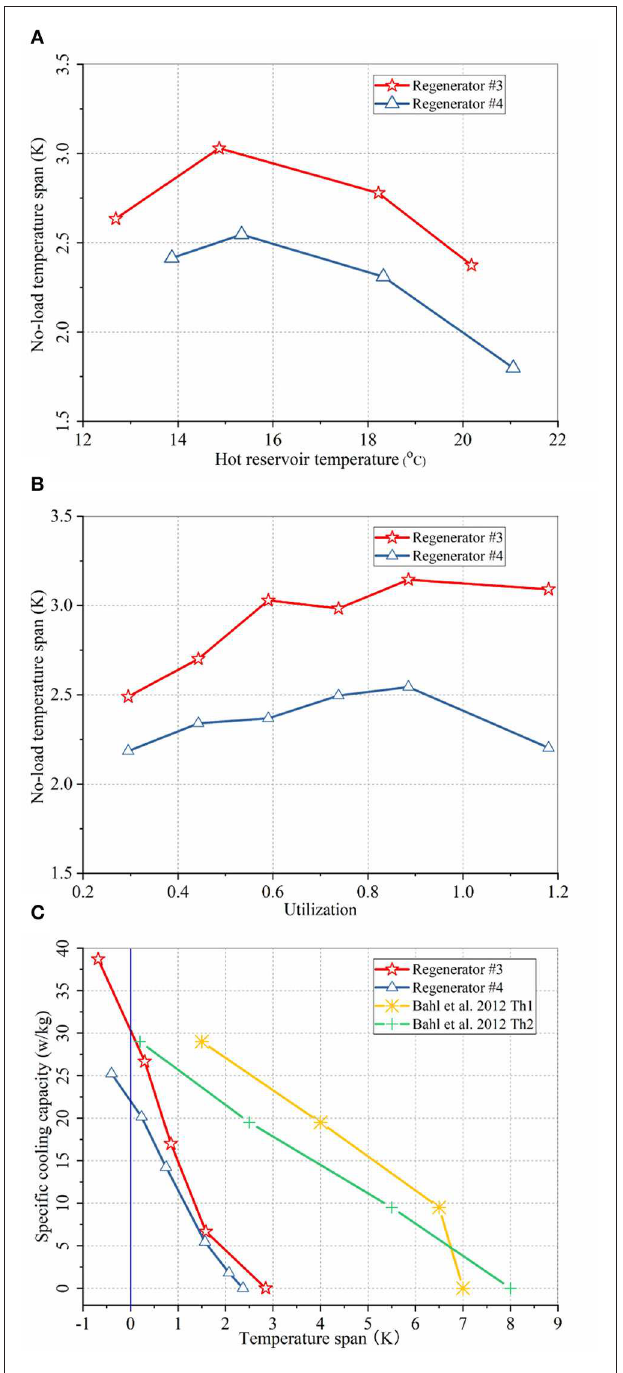
FIGURE 8 | (A) Temperature span as a function of hot reservoir temperature at a utilization of 0.59 between regenerators #3 and #4. (B) Temperature span as a function of utilization at hot reservoir temperature of regenerators #3 and #4. (C) Specific cooling capacity vs. temperature span (cooling curves) at utilization of 0.59 and hot reservoir temperature of between regenerator #3 and #4, and cooling curves from a parallel plate regenerator with similar MCM at utilization equals 0.5. T h 1 and T h 2 mean the hot reservoir temperatures are 8 ◦ C and 11 ◦ C, respectively. The MCM in parallel plate regenerator is layered by two LCSMx with different Curie temperatures, which the MCM in freeze-cast regenerators is LCSM of single